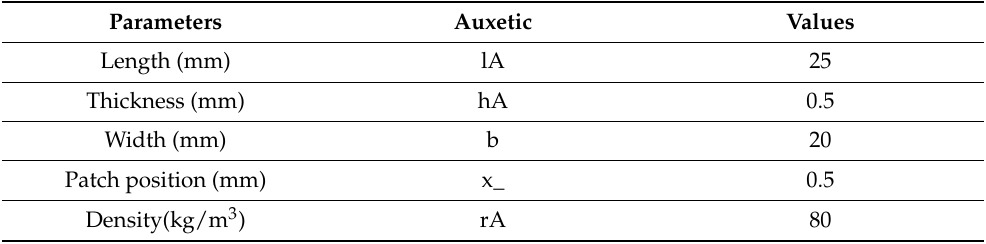
Table 6. Numerical values of system parameters.